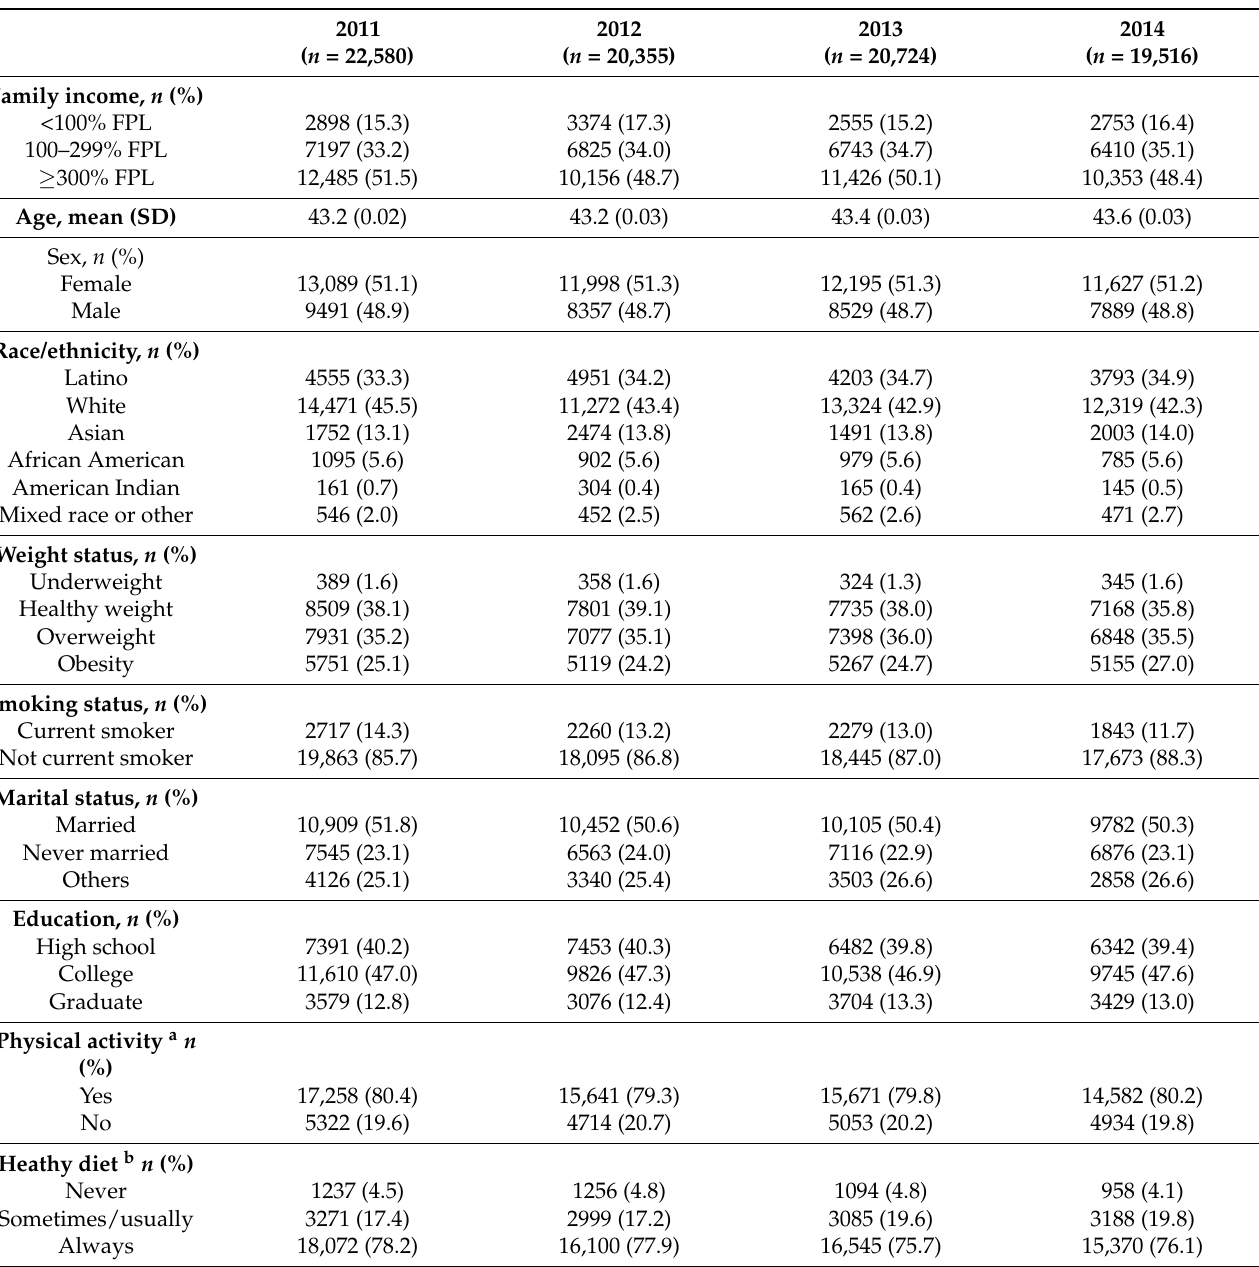
Table 1. The participants’ characteristics of Californian adults by each survey year from